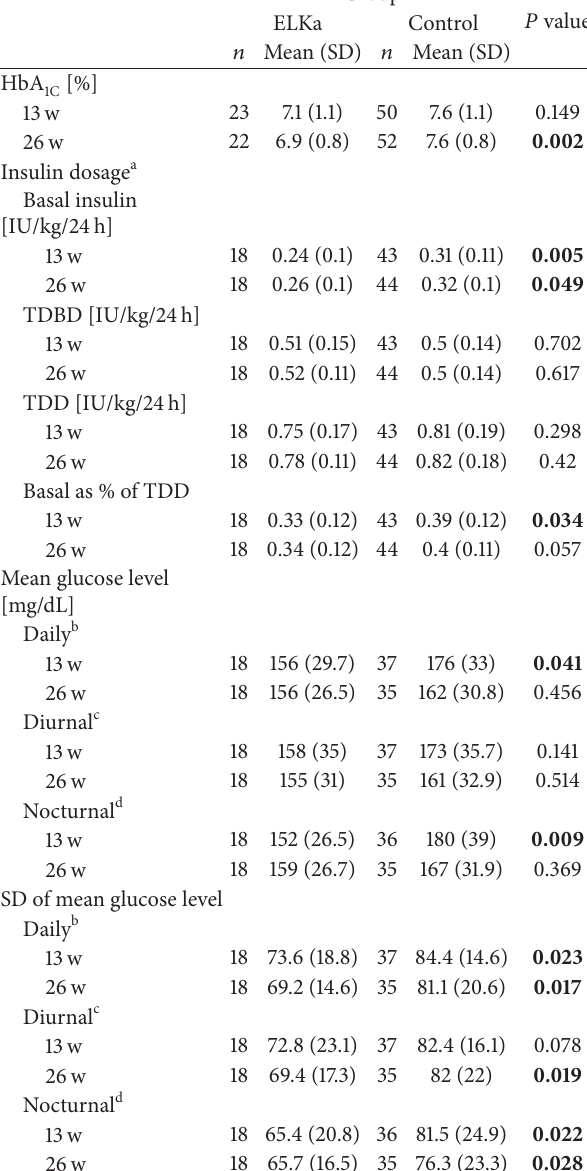
Per protocol analysis concerns patients who received allocated intervention and declared ELKa system usage for more than 50 % of meals. 𝑛 , number of patients included in analysis; w, weeks; TDBD, total daily dose of bolus insulin; TDD, total daily dose of insulin. Units are listed in square brackets in the first column. a Data downloaded from insulin pumps. b Data downloaded from blood glucose meters, measured over 24h. c Data downloaded from blood glucose meters,measuredbetween07:00AMand09.59PM. d Datadownloadedfrom blood glucose meters, measured between 10:00 PM and 06:59